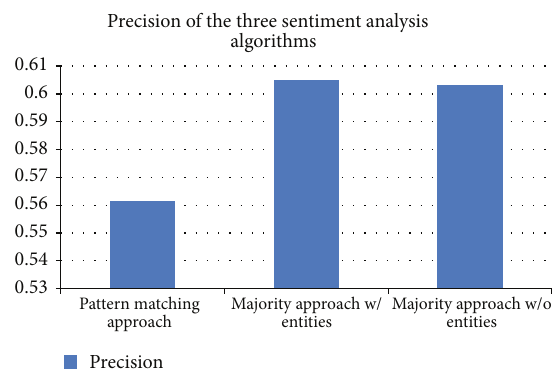
Figure 4: Benchmarking the precision results of the three different variations of the classification